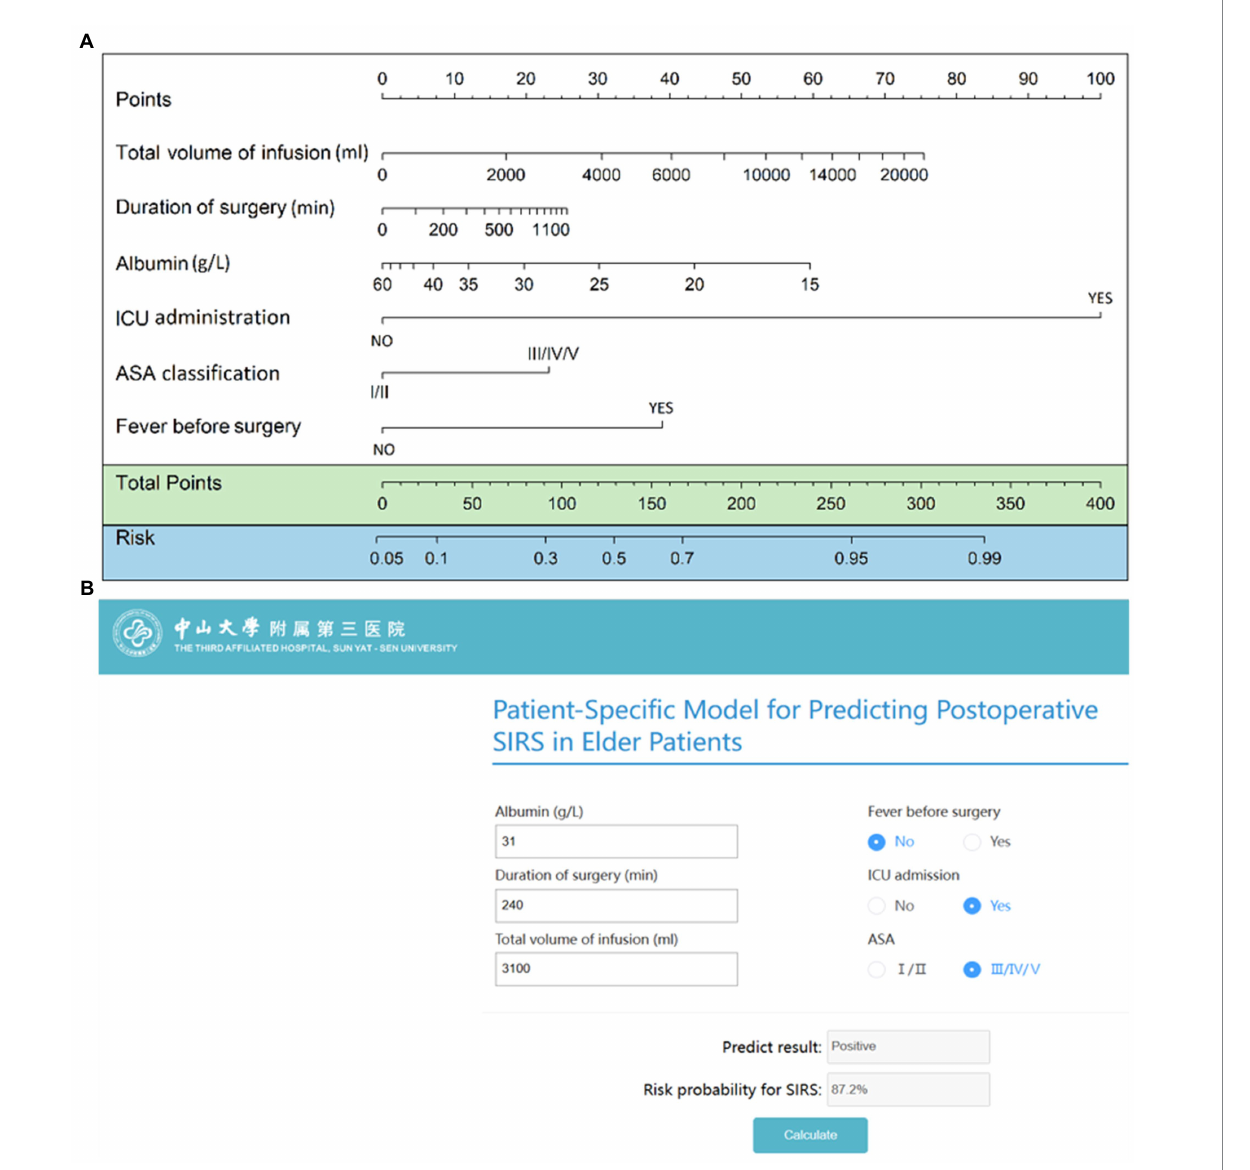
FIGURE 3 Nomogram and browse-based calculator to predict postoperative SIRS in older patients. (A) The nomogram to predict postoperative SIRS was created based on 6 independent feature variables, including preoperative fever, preoperative serum albumin level, ASA classification, total intraoperative infusion volume, surgical duration, and postoperative intensive care unit admission. (B) Browse-based calculator that can be used to help make clinical decisions regarding the potential risk of postoperative SIRS in older patients. The browse-based tool can be visited at